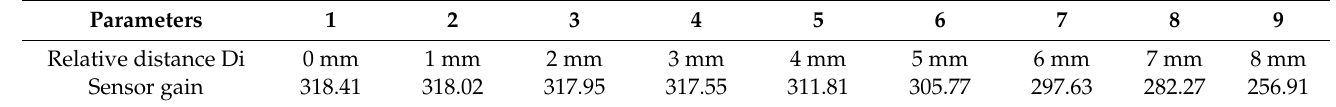
Table 4. Change the position of the measurement conductor with respect to the probe.